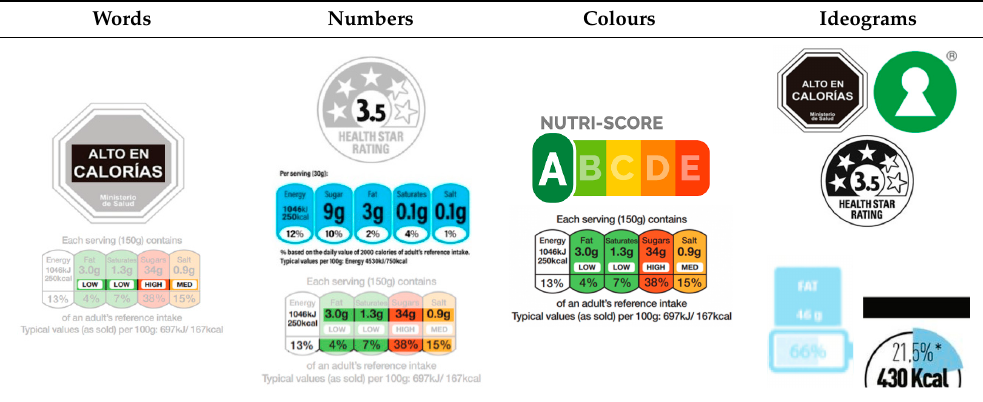
Appropriate signs are highlighted. From left to right and top to bottom: Warning Signs, Multiple